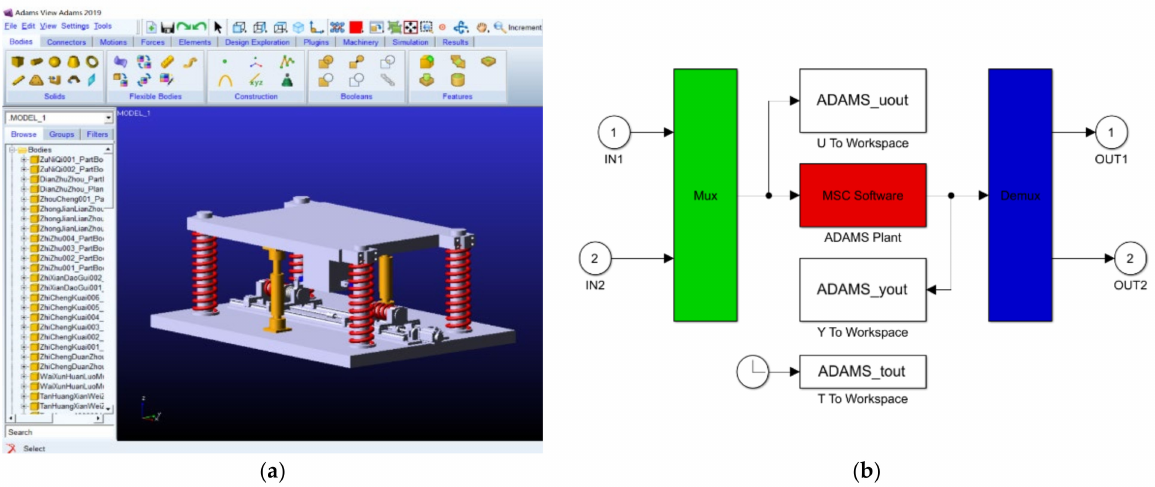
Figure 16. ADAMS Simulation operation interface: ( a ) simulation model; ( b ) the interactive module Adams and Simulink.